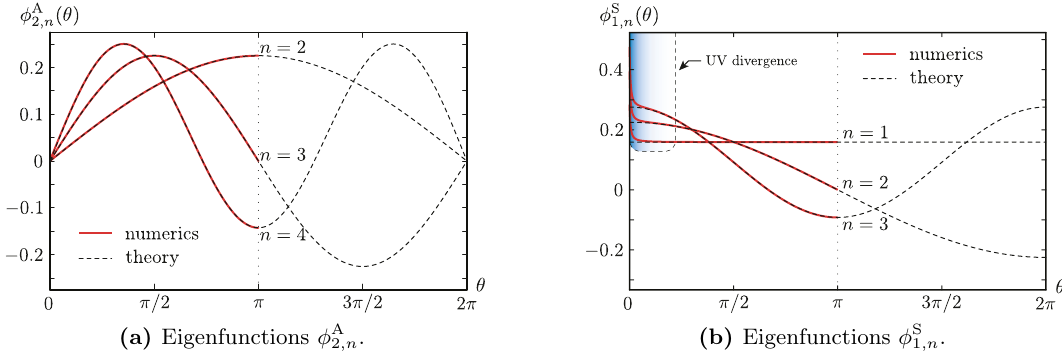
Figure 6. (a) Plot of numerical k S (1 ; 1) for q = 4 and n = 1. The dashed line is the (cid:12)t (4.13). (b) Plot for n(cid:11) S ( n ) for q = 4. One can see that within computational accuracy (cid:11) S K depend on n , con(cid:12)rming the expectation (4.11). We use 10 8 grid points for numerical computation of G ( (cid:18) ) and 10 5 grid points for the kernel discretization in (cid:18) and (cid:18) 0 directions, so the kernel becomes a 10 5 (cid:2) 10 5 matrix.